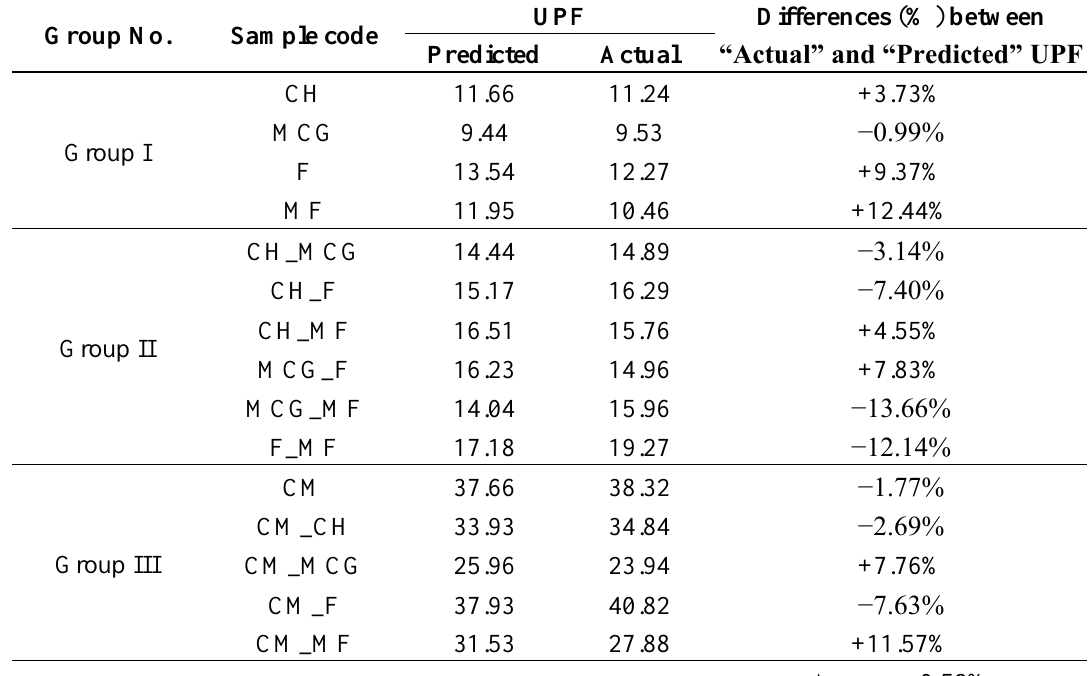
. dry and relaxed